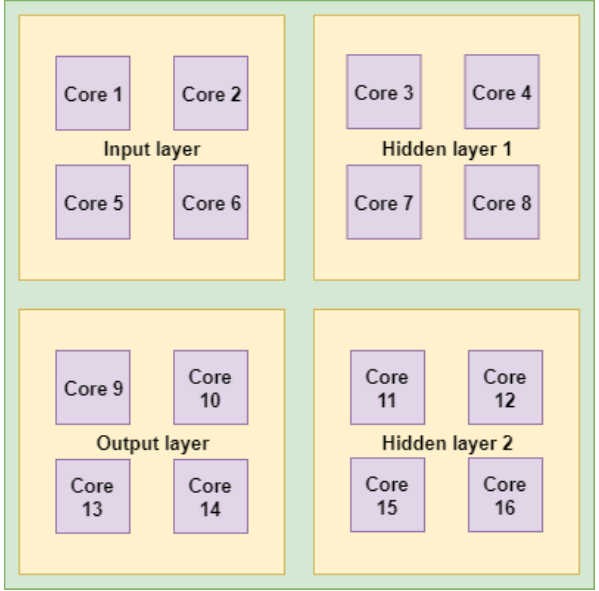
Figure 12. Level-1 mapping for 16-cores architecture using multilevel mapping technique.